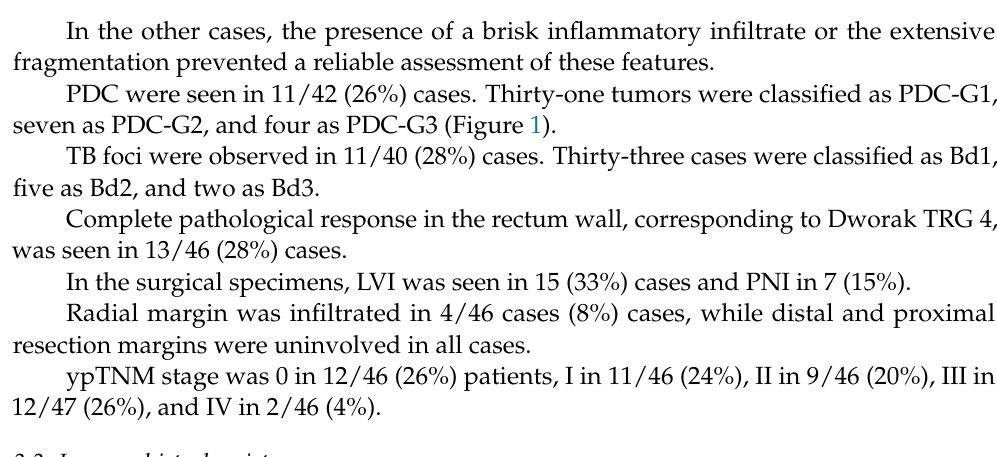
Figure 2. Poorly differentiated clusters ( A ) and tumor budding foci ( B ) in the pre-treatment endo- scopic biopsy of rectal carcinoma.